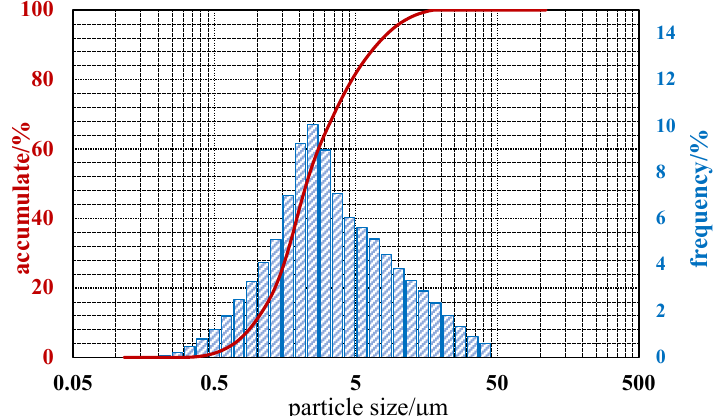
Figure 1. Particle distribution curve of Bayer red mud.